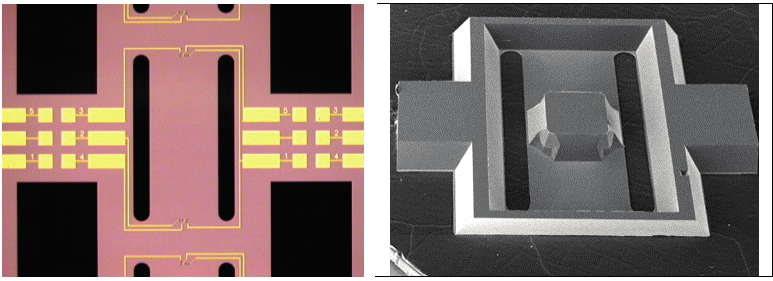
Figure 7. Fabricated SOI sensor chip. Left —top view, and Right —bottom view of the fabricated device [9].